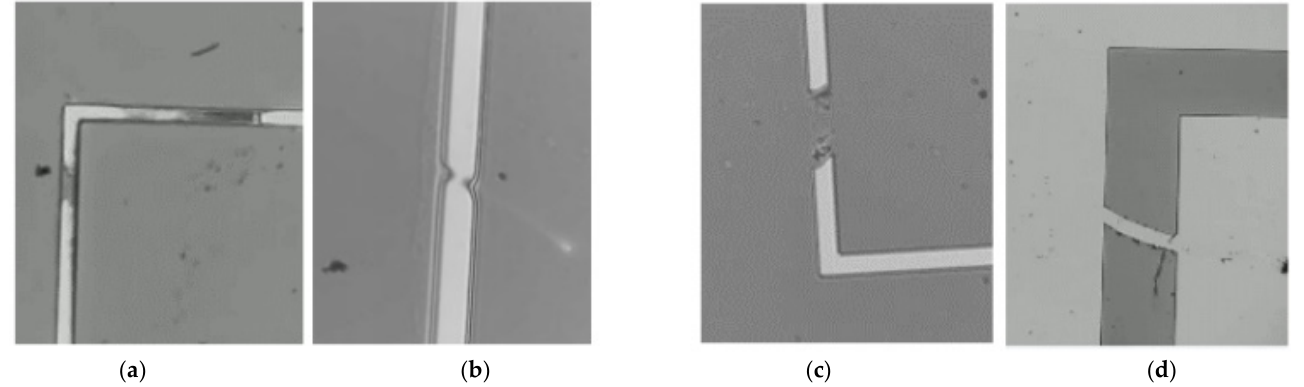
Figure 2. ( a ) Open defects, ( b ) short defects, ( c ) line contamination, and ( d ) bite defects in a pa(cid:308)erned wafer defect map.